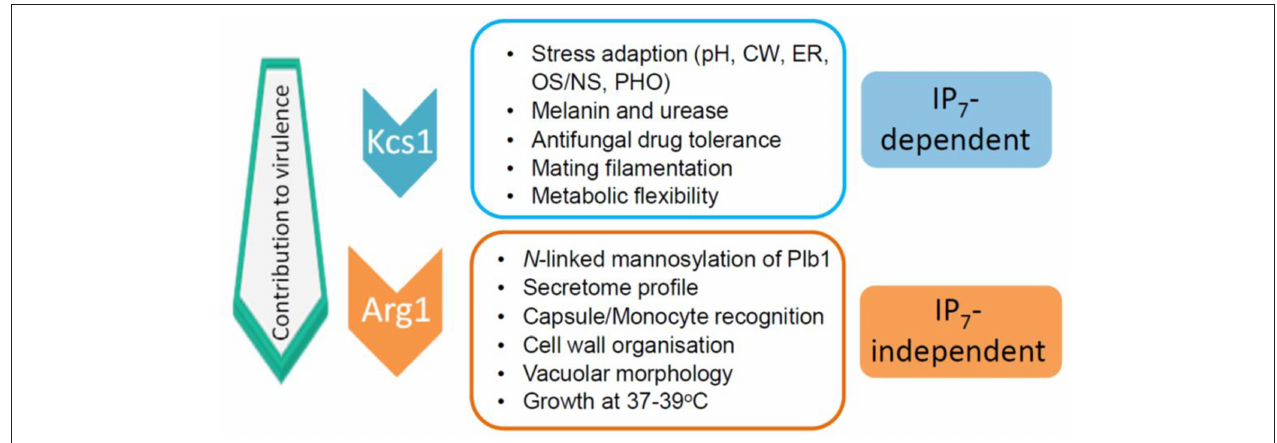
FIGURE 2 | IP 7 -dependent and IP 7 -independent functions conveyed via CnArg1. Due to these combined functions, the contribution of CnArg1 to fungal virulence is greater than that of CnKcs1. pH—alkaline pH stress; CW—cell wall stress induced by calcofluor white, Congo red, SDS and caffeine; ER—endoplasmic reticulum stress caused by tunicamycin and DTT; OS/NS—oxidative and nitrosative stress; PHO—low